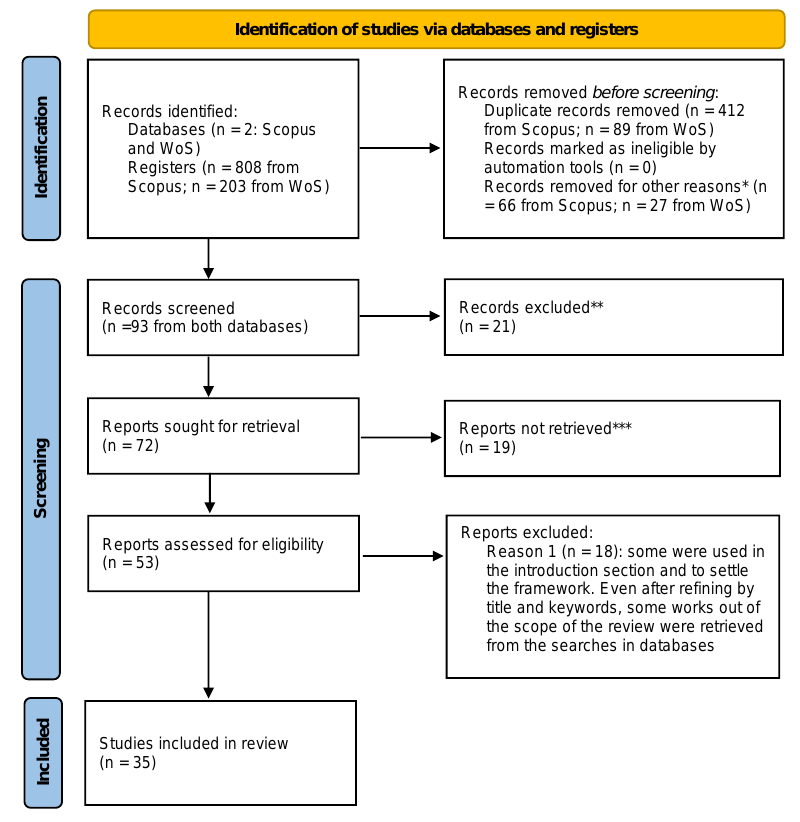
Figure 1. Flow diagram for the literature search.